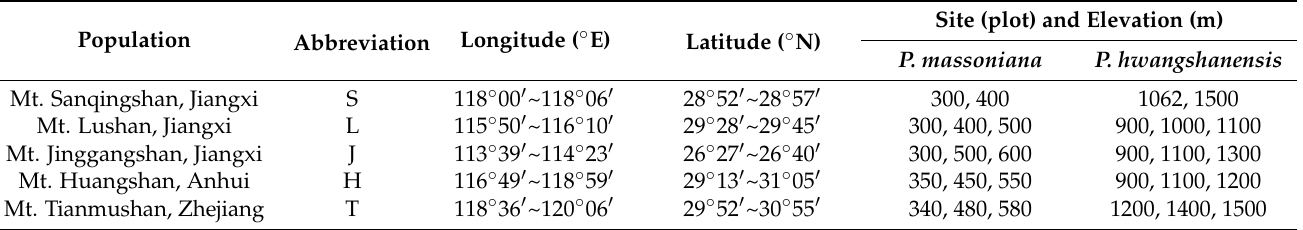
Table 4. The geographic locations of sampling populations in P . massoniana and P. hwangshanensis .